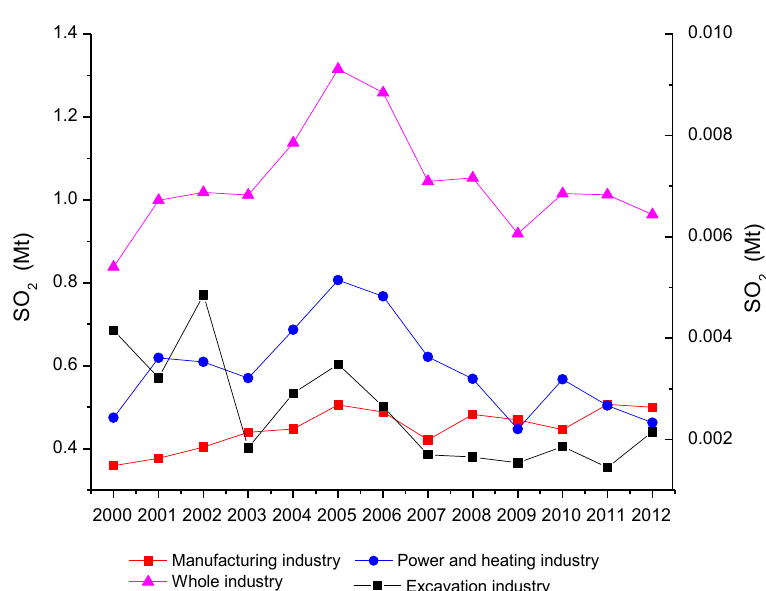
Figure 2. Variations of industrial SO 2 emissions in the excavation, manufacturing and power and heating industries from a survey dataset in Jiangsu province during 2000–2012 (JSPBS, Jiangsu Provincial Bureau of Statistic, 2011–2013) [12].